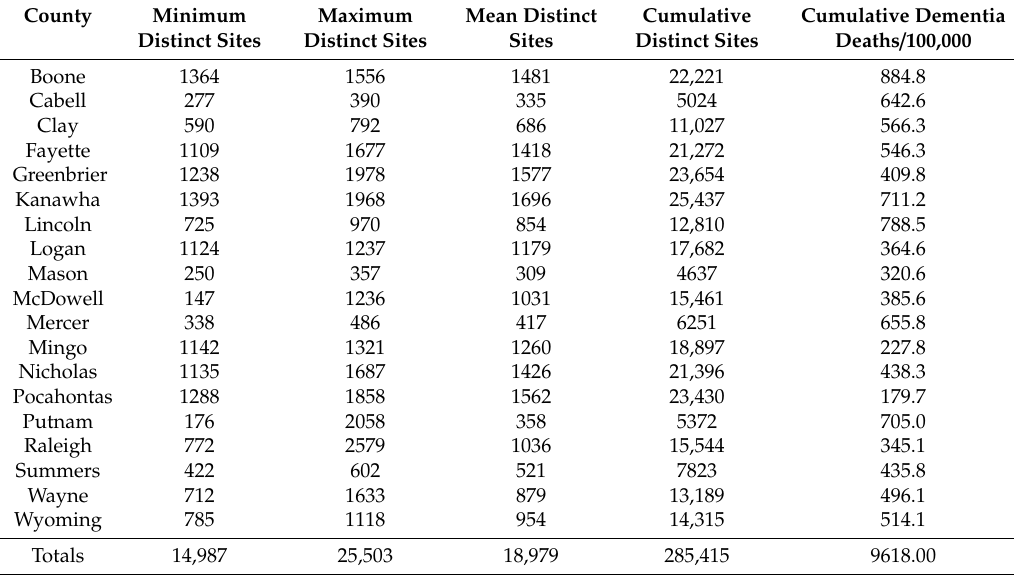
Table 1. Mining site data and cumulative dementia deaths 2001–2015 by